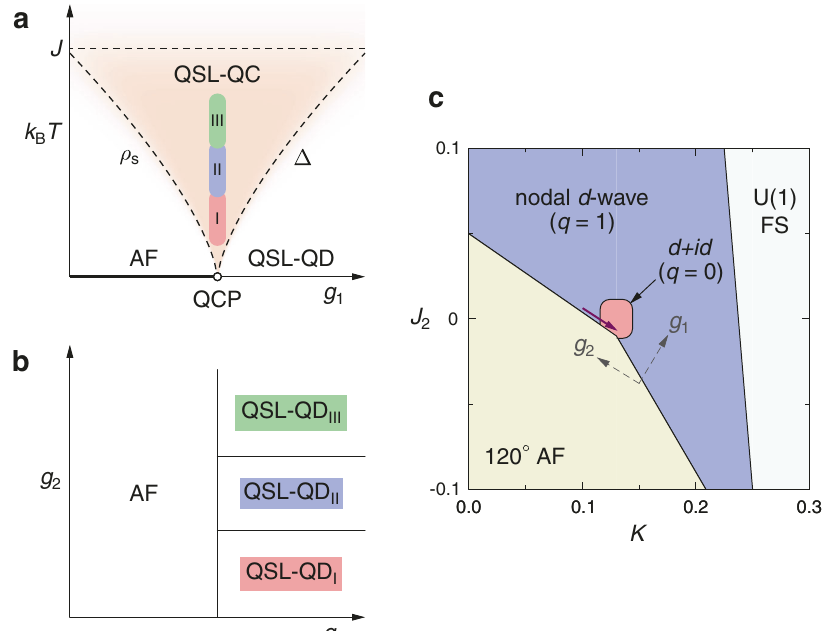
Fig. 6 Phenomenological interpretation and comparison with theory. a The QC spin liquid model has a QCP between an AF phase, in this case the 120° non-collinear state (thick line) and a gapped quantum disordered QSL-QD Z 2 spin liquid phase. The QPT is tuned by a control parameter g 1 and at the QCP, the spin stiffness ρ s and the QSL gap Δ both reduce to zero. The experiments at fi nite temperature T indicate QSL phases that are gapless and thus close to being directly above the QCP in the QSL-QC region, suggesting that the actual g 1 value closely matches the position of the QCP and does not have a strong T dependence. The fan-shaped QC region is bounded by three crossovers (dashed lines). On the low side, these re fl ect ρ s and Δ . The exchange coupling J would normally provide the high limit, but T nC actually occurs fl ect the stabilization of different QSL phases. c A reported triangular lattice phase fi rst here. b A second parameter g 2 is introduced to re diagram from variational studies 40 . The control parameters are the second-nearest-neighbor exchange J 2 and the four-site ring exchange K , both normalized to J . Close to the AF state, the d + id state and the nodal d -wave state strongly compete, leading to a pocket of stability for the d + id state. Dashed lines show possible J 2 – K mapping of the parameters g 1 and g 2 . The purple arrow shows a possible parameter path for 1T-TaS 2 on cooling through regions II and